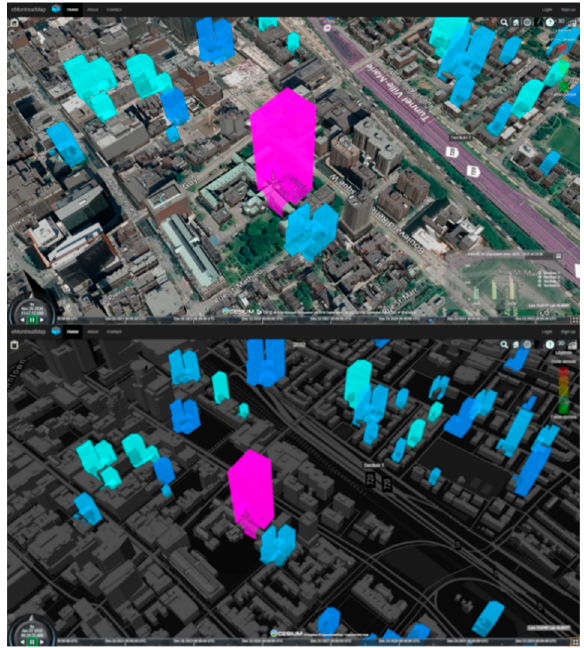
Figure 5. Scenario #2 with future buildings proposed in different blue tone. The selected building is shown in pink and is planned to be built on a heritage site (i.e., church). Image also shows the realistic photo with texture.